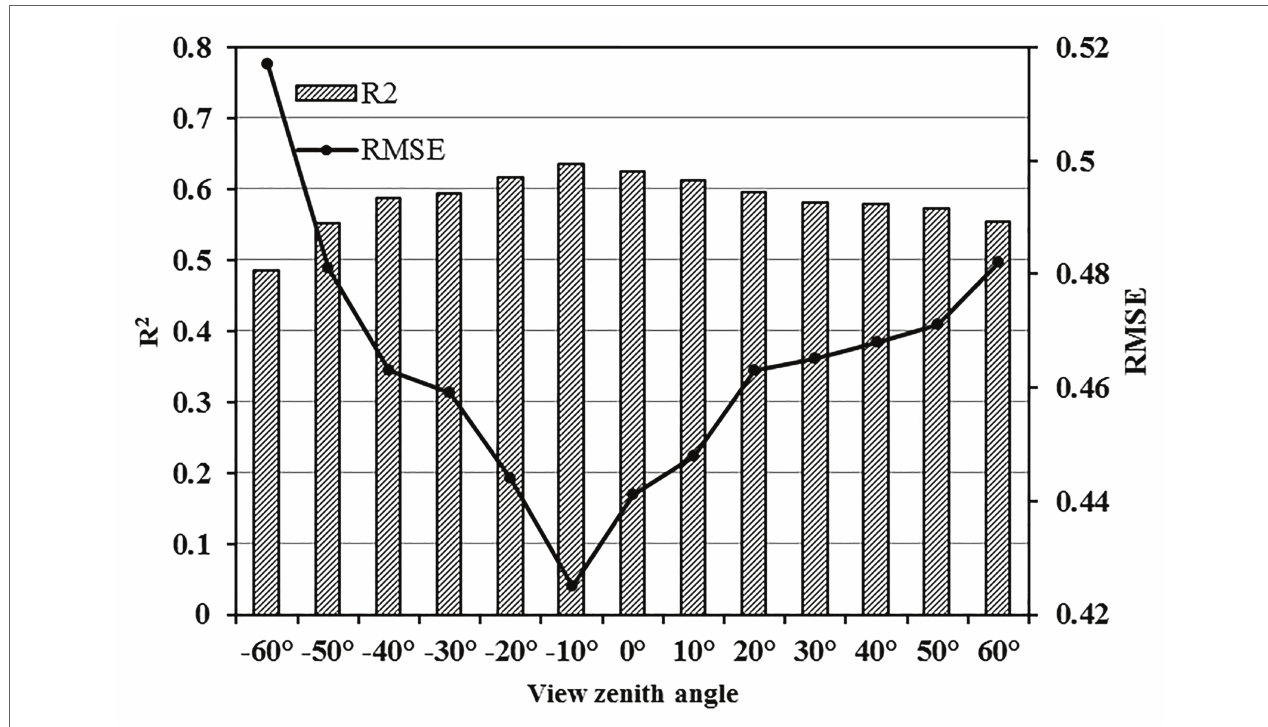
FIGURE 6 | Correlations between water efficiency index (WEI) and WUE at different zenith angles ( n = 140).